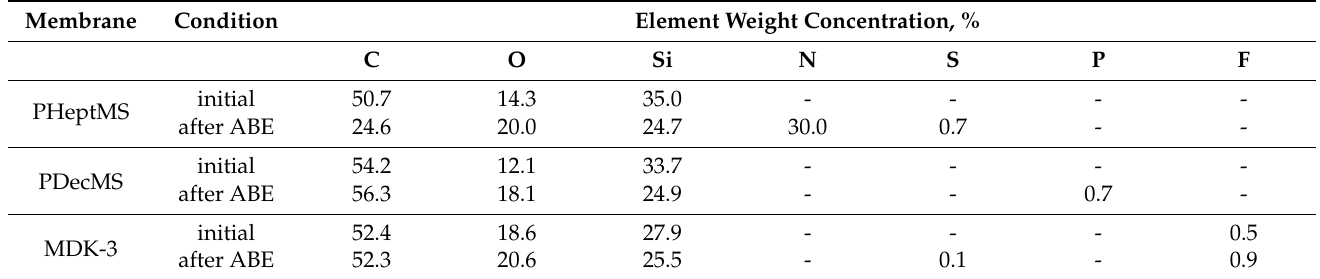
Table 1. EDX analysis data of PHeptMS, PDecMS, and MDK-3 membranes before and after contact with the fermentation broth.